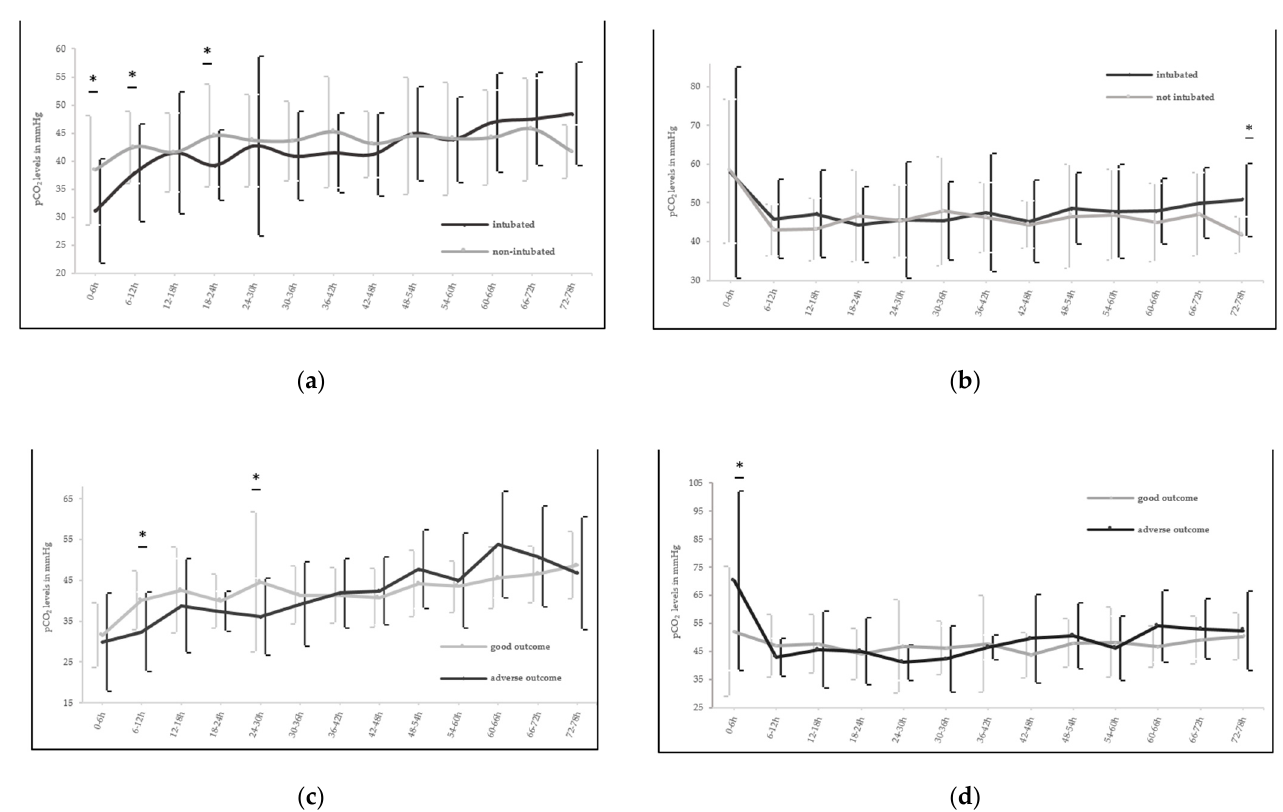
Figure 2. Significant differences between lowest and highest partial pressure of carbon dioxide (minimum and maximum pCO 2 ) correlated with outcome and ventilation status. Temporal course of minimum ( a ) and maximum pCO 2 ( b ) over the first 78 h after initiation of TH, examined every 6 h, in association with ventilation status and course of minimum ( c ) and maximum pCO 2 ( d ) over the first 78 h after initiation of therapeutic hypothermia (TH) compared to outcomes in the subgroup of intubated newborns. Values are represented as mean ± standard deviation (SD), * p < 0.05.